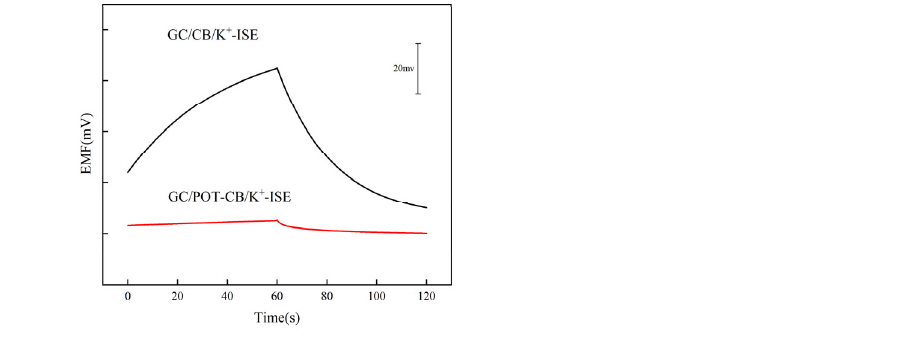
Figure 4. Reverse chronopotentiometric curves of GC/POT-CB/K + -ISE and GC/CB/K + -ISE.